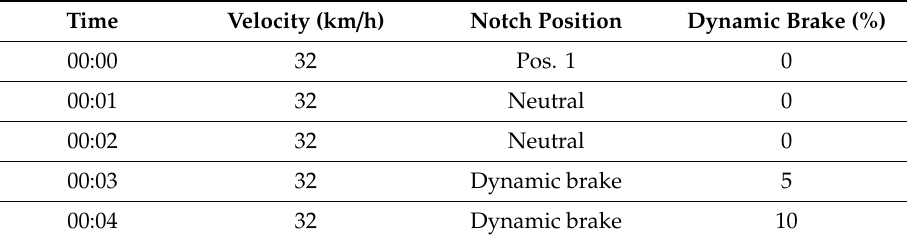
Table 3. Sample of data from the train’s black box during a